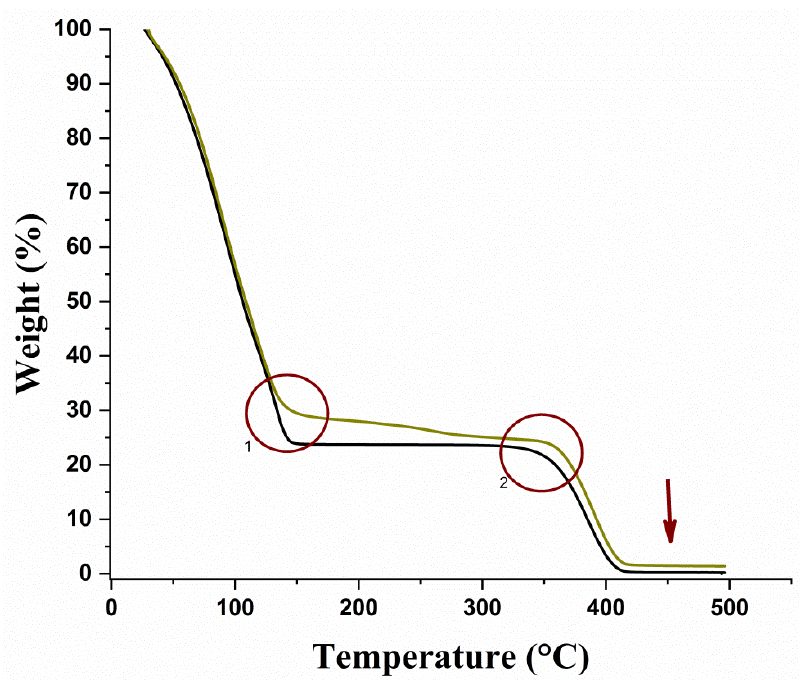
Figure 2. TGA curves of VADE-loaded-hydrogel (green curve) and without VADE (black curve) in the range from 30 to 500 ◦ C. The first thermal degradation occurred at 30 ◦ C to 143 ◦ C and was attributed to water loss. The second stage started at 350 ◦ C, and at 410 ◦ C a total decomposition of Pluronic ® F127 was registered. Circle 1 highlights the difference in mass weights between VADE- loaded-hydrogel (green curve) and the sample without VADE (black curve). Circle 2 shows that the polymer decomposition occurred at different temperatures, starting at 346 ◦ C in the absence of VADE, and at 365 ◦ C in the presence of VADE. The arrow indicates the presence of mineral residuum in the VADE- loaded-hydrogel.